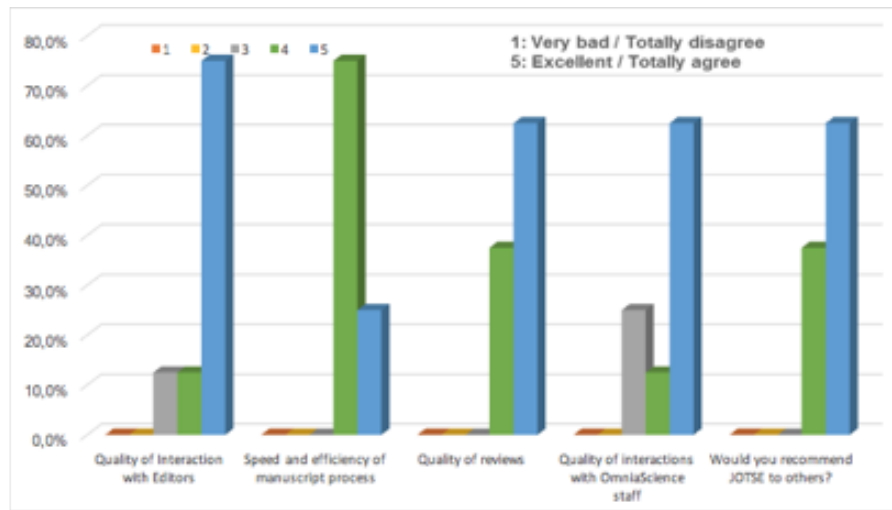
Figure 2. JOTSE author survey results